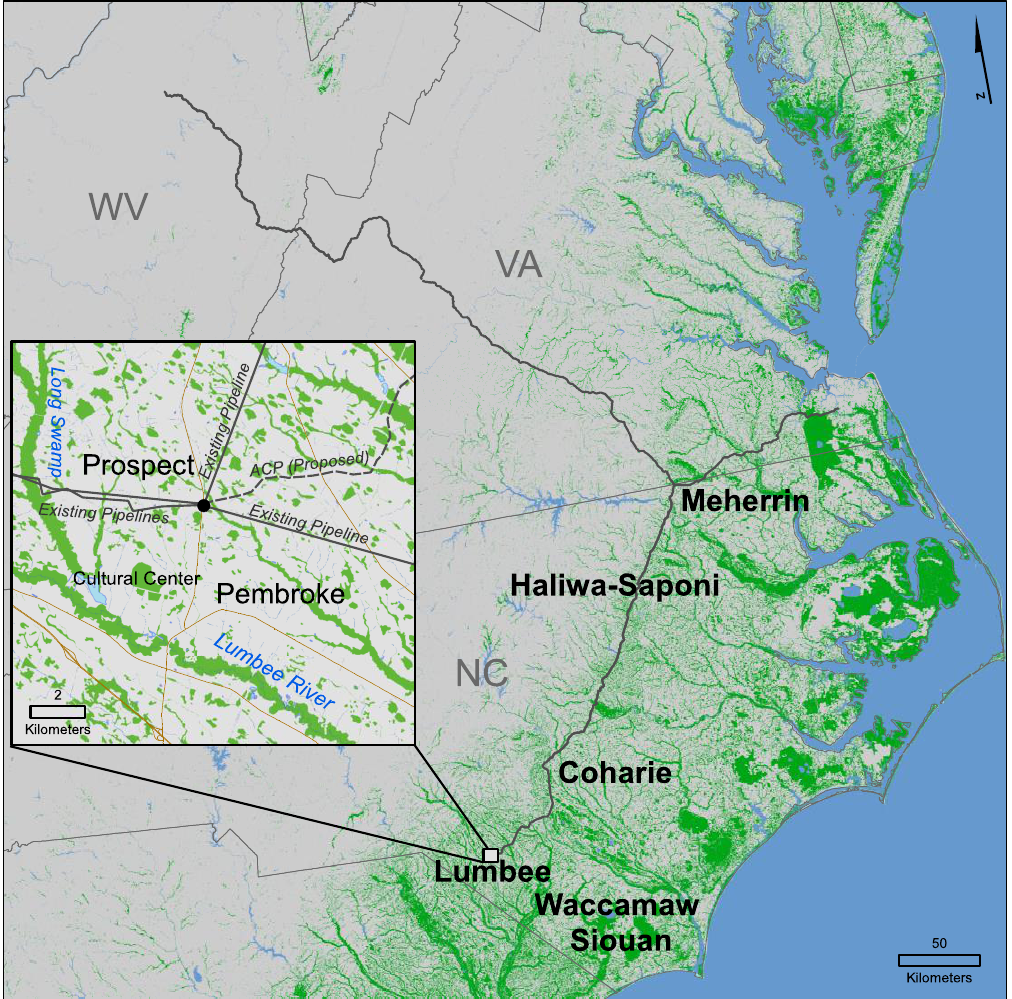
Figure 3. Proposed route of the Atlantic Coast Pipeline through West Virginia, Virginia, and North Carolina. Present-day territories of affected Tribal nations in eastern North Carolina are shown along with wetland land cover (green) and inland water bodies (blue) derived from the 2016 National Land Cover Dataset. Inset shows area surrounding Prospect, where developers proposed to build the Atlantic Coast Pipeline’s terminal infrastructure (black circle). Highways and local roads (brown) are shown for additional geographic reference.